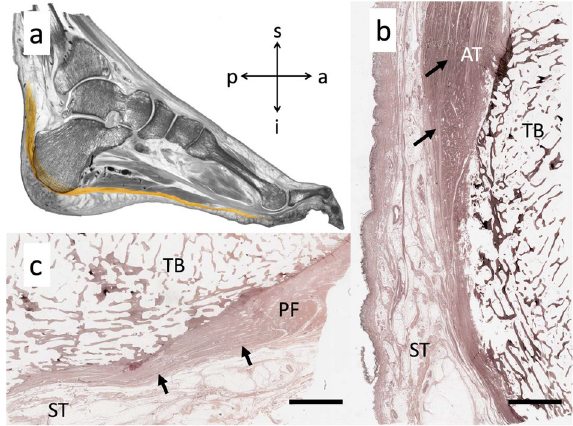
Figure 5. Image ( a ) shows a representative section of an E12-plastinate in the sagittal plane in black and white with the area of interest in this study in natural color. The aligned dense trabeculae within the superficial posterior-inferior calcaneus appear to be the continuation of the Achilles tendon (AT) towards the plantar fascia (PF). The location of the histological sections 4b and 4c is indicated with dotted squares. Image ( b ) shows a silver staining of calcaneal trabecular bone (TB) and the inserting AT. Superficial to the calcaneus, the AT subcutaneous tissue (ST) is depicted. The black arrows point to the collagen bundles of the AT running from superior to inferior in this slice. Image ( c ) shows a silver stained slice of the foot in the area of the PF. Several bundles of collagens jointly run in an anisotropic fashion (black arrows). Scale bar, 5 mm.